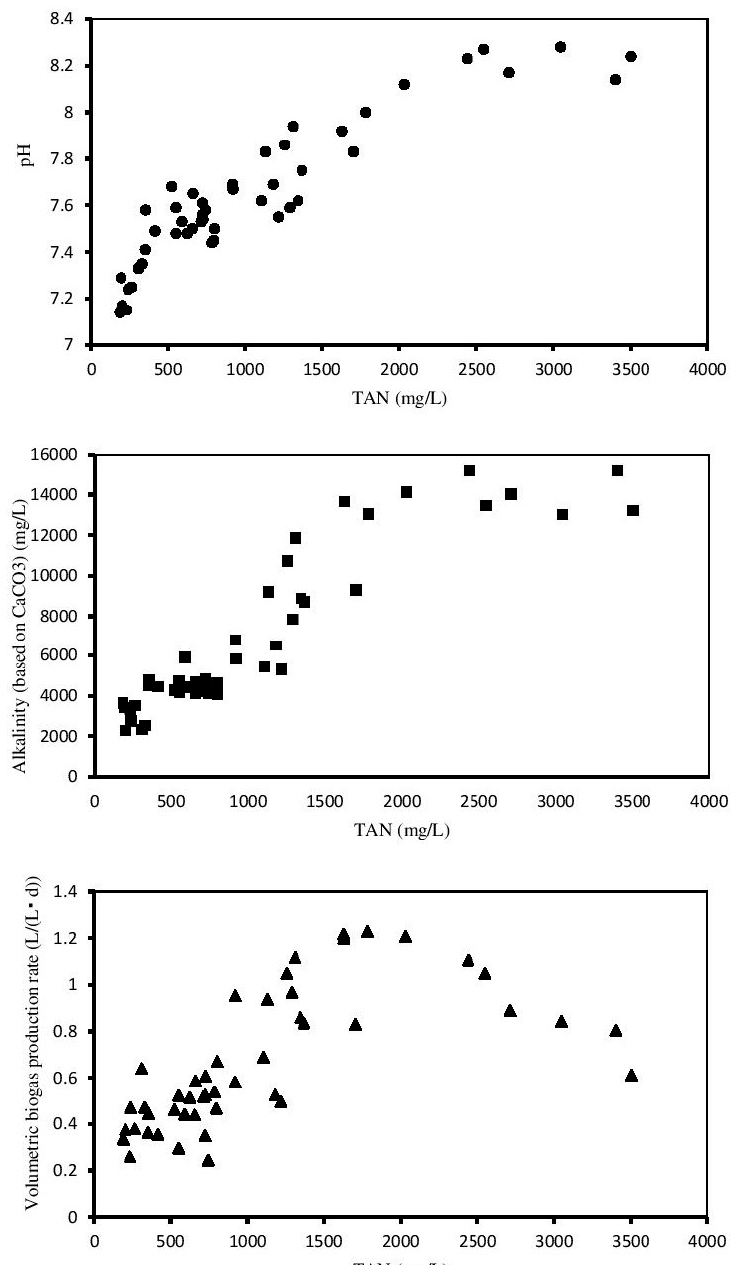
Figure 5. Effect of TAN on the pH, alkalinity, and volumetric biogas production rate. (TAN is not an independent variable here; it may also correspond to one or more dependent values.)